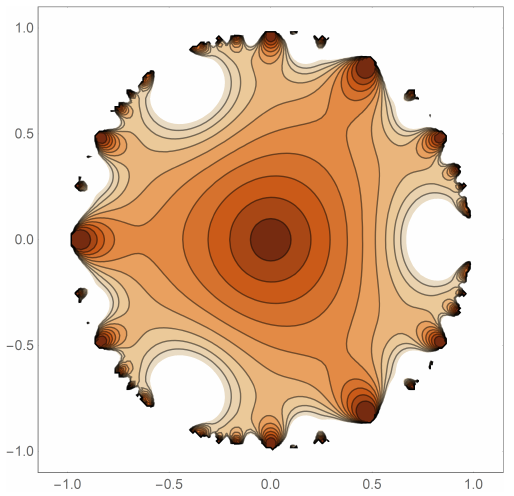
( 3 ) ( z ) . The three-fold rotational symmetry is 10